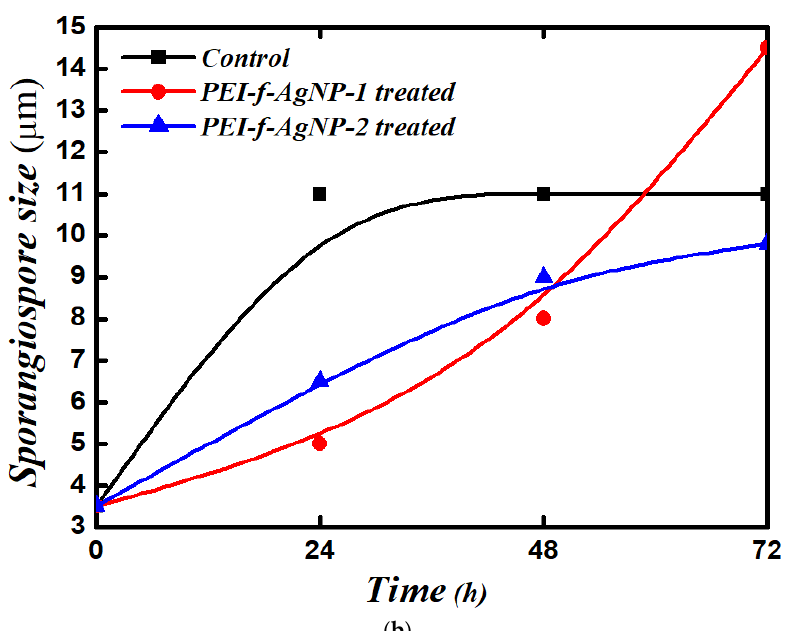
Figure 4. ( a ) Size distribution histogram of PEI-f-Ag-NPs treated sporangiospores: ( i ) freshly har- vested sporangiospores, ( ii ) fully germinated sporangiospores at 24 h, ( iii ) PEI-f-AgNP-1 treated sporangiospores at 24 h, ( iv ) PEI-f-AgNP-2 treated sporangiospores at 24 h, ( v ) PEI-f-AgNP-1 treated sporangiospores at 48 h, ( vi ) PEI-f-AgNP-2 treated sporangiospores at 48 h, ( vii ) PEI-f-AgNP-1 treated sporangiospores at 72 h, and ( viii ) PEI-f-AgNP-2 treated sporangiospores at 72 h. ( b ) Average sporangiospore size during germination at various times (24–72 h) in PEI-f-Ag-NPs treated and control sporangiospores.